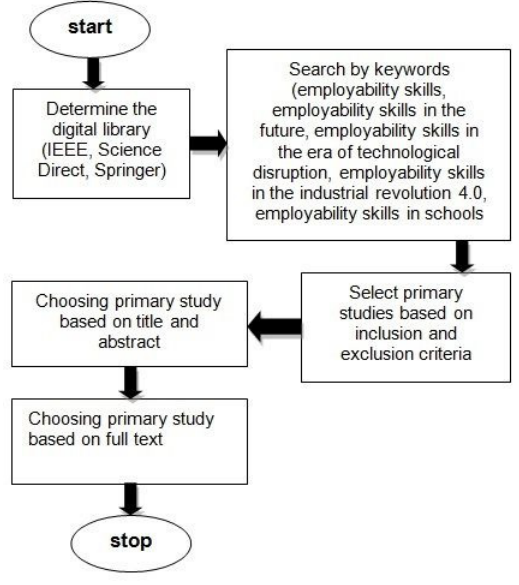
Figure 1: Flowchart of Identification and Select